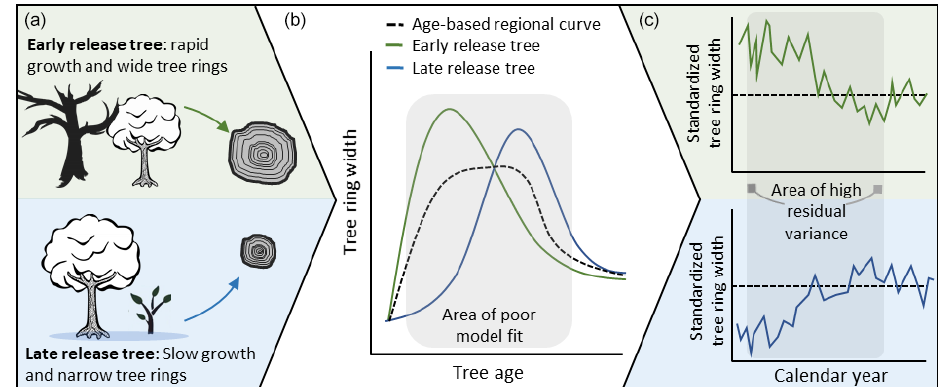
Figure 1. (a) In shade-tolerant species, young trees are stochastically released from low-light suppression in the understory. (b) Since release from suppression is not strictly related to tree age, widely used communal age trend models (RCS) poorly model tree growth in the period following establishment and leading up to the age when most trees have been released from suppression. (c) Poor model fit in this period implies that the biological growth trend is not entirely removed from individual series and leads to high residual variance when standardized tree ring series are aligned according to calendar